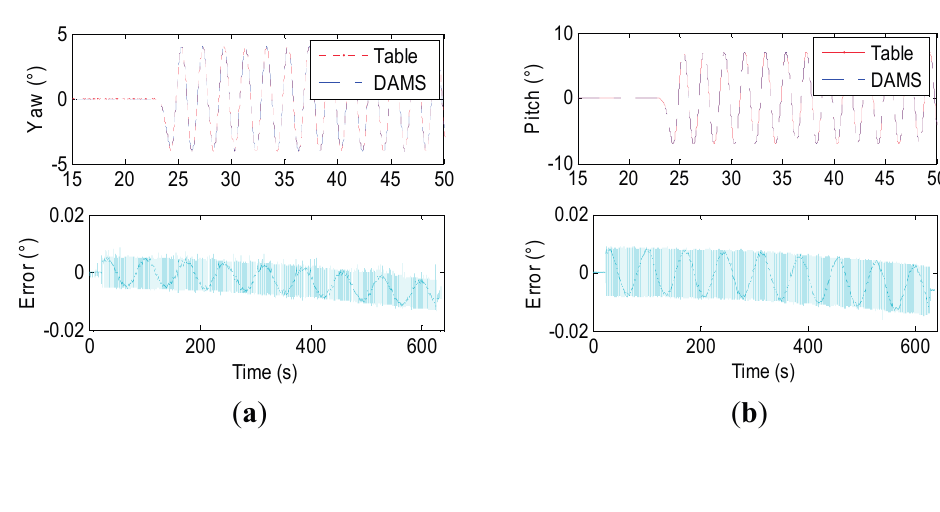
Figure 19. Three axes wobbling test process and error curves (0.5 Hz). ( a ) Yaw, ( b ) Pitch, ( c )